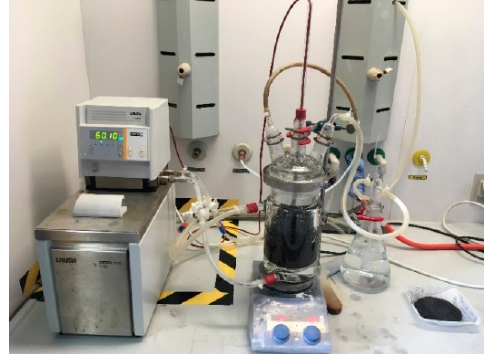
Figure 4. Setup of the leaching process under optimized conditions in the laboratory (double walled reaction vessel with a reaction volume of one liter and a thermostat to control the chosen process temperature).